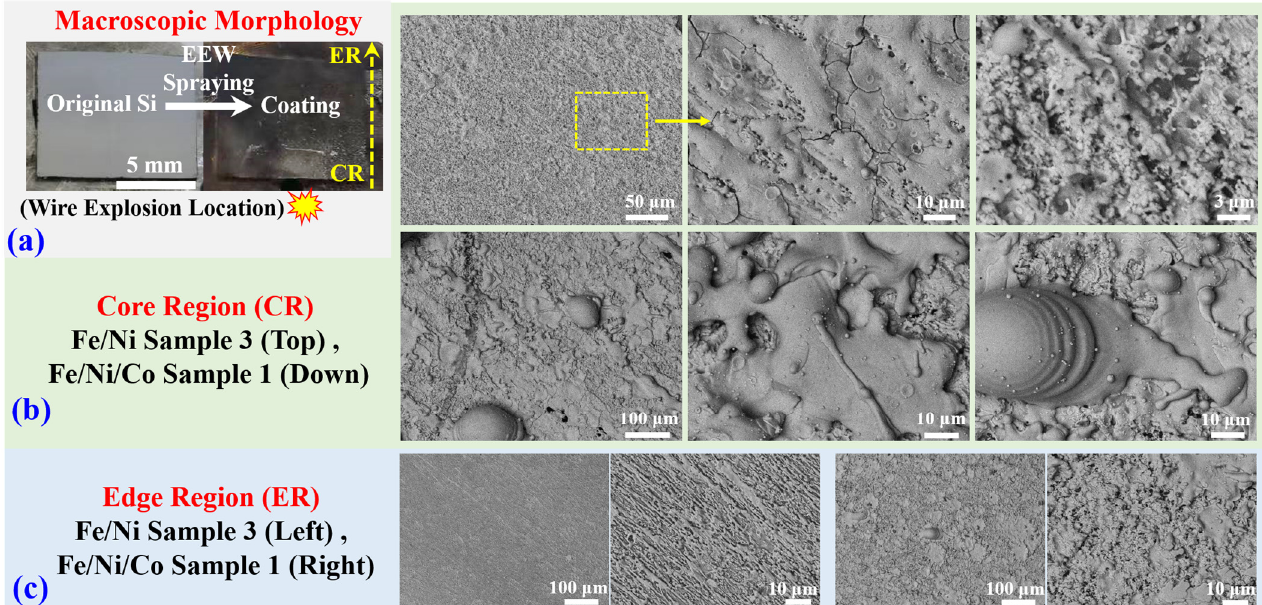
Figure 3. Si substrate after spraying: ( a ) macroscopic morphology; ( b ) microcosmic SEM images of both samples in the CR; ( c ) microscopic SEM images of both two systems in the ER.